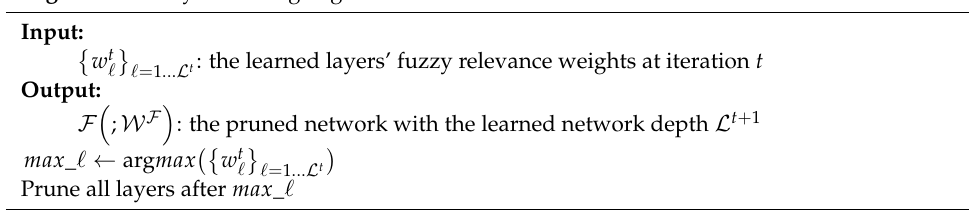
Algorithm 2: Layer Pruning Algorithm